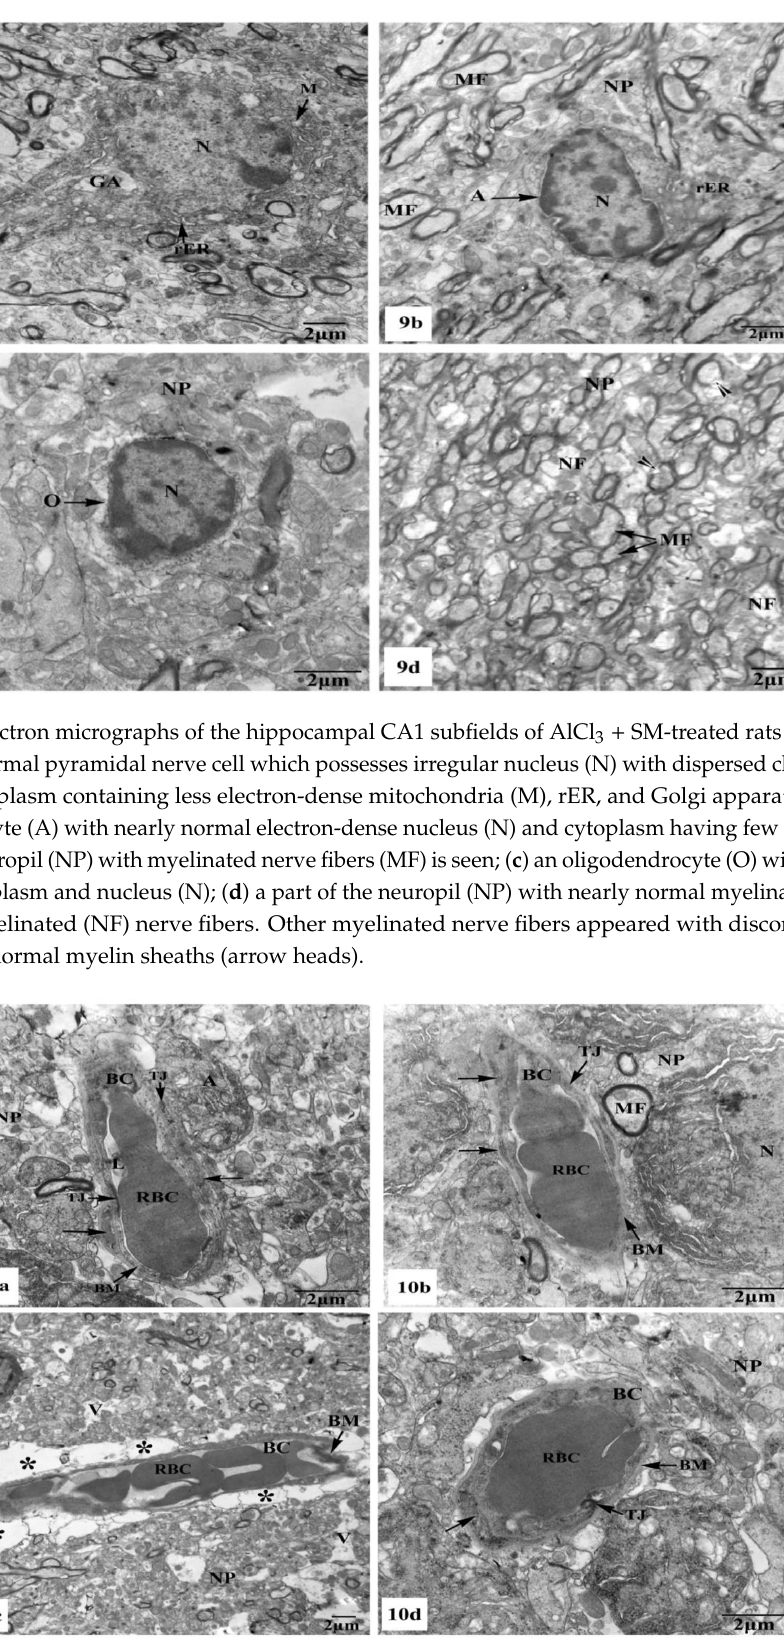
Figure 10. Electron micrographs of the blood–brain barrier (BBB) in the hippocampal CA1 subfields showing ( a , b ) intact blood capillaries (BC) with narrowed lumens (L) containing red blood cells (RBCs) and appearing with continuous and integrated basement membranes (BM) that have normal tight junctions (TJ) and surrounded by many astrocyte processes ( ← ) in control and SM-treated rats, respectively; ( c ) a blood capillary (BC) surrounded with greatly expanded astrocyte processes (*) and its basement membrane was disrupted and the tight junctions were unclear, besides, the surrounding neuropil (NP) revealed vacuolation (V) are seen in AlCl 3 -treated rats; ( d ) nearly normal blood capillary (BC) enclosing red blood cells (RBCs) in its narrowed lumen and surrounded with intact basement membrane (BM) showing tight junctions (TJ), in addition, the surrounding foot processes ( ← ) of the adjacent astrocyte appeared normal in AlCl 3 + SM-treated rats. 4. Discussion Al is reported as a potent neurotoxin and has been associated with AD since it exacerbates brain oxidative injury, causes neuronal inflammation, and induces Aβ deposition, which leads to impairment in working memory [9,31]. It accelerates LPO and induces increased free radical generation, thereby causing oxidative stress, which results in severe neurotoxicity [32]. The brain is known to be most susceptible to the adverse influences of Al, and it is especially vulnerable to oxidative stress resulted from elevated levels of free radicals and diminished levels of antioxidants following toxicity [33]. A large group of neurodegenerative diseases, characterized by progressive loss of central neurological function, has been recorded in infancy and childhood [34]. Therefore, the present research was performed to study the potential neuroprotective role of SM against AlCl 3 -induced Alzheimer-like disease in early adult rats through biochemical, histological, and ultrastructural analyses. Free radicals are a group of highly reactive molecules, which form as natural derivatives of biochemical reactions occurring inside the living cells. These substances comprise reactive nitrogen (RNS) and oxygen (ROS) species and they can react readily with the cellular macromolecules such as proteins, carbohydrates, lipids, and nucleic acids causing huge harm to cell structures [35]. Living cells produce endogenous anti-oxidative factors, which buffer the generated free radicals and